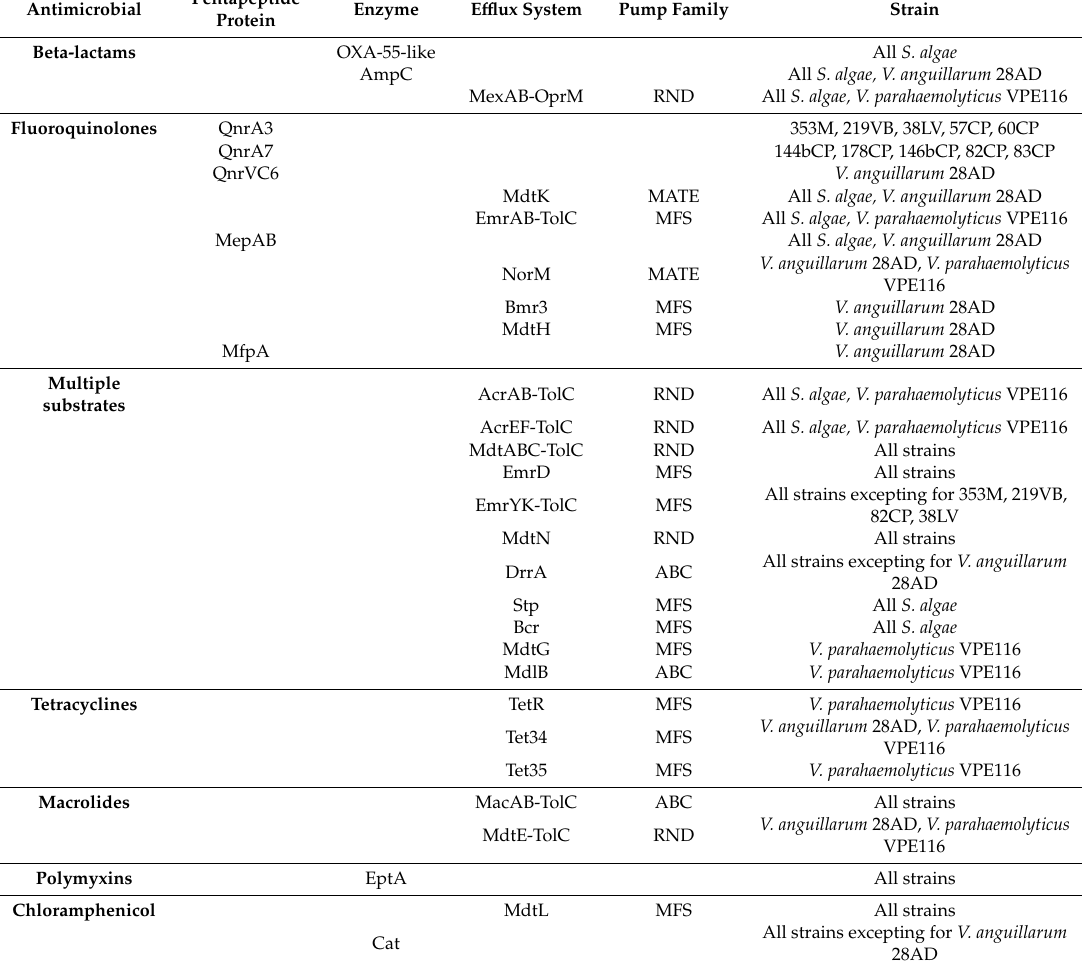
Table 2. List of resistance genes found in S. algae and Vibrio spp. grouped on the basis of their mechanism and antimicrobial